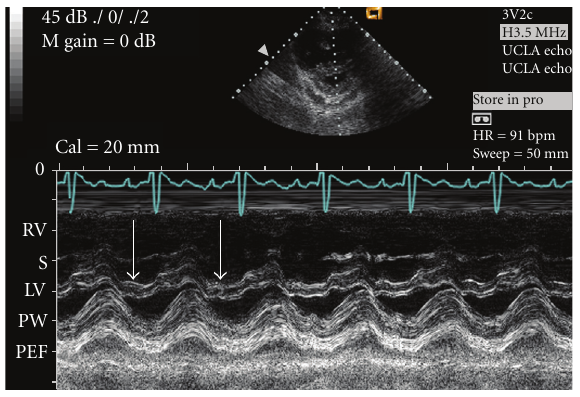
Figure 3: M-mode echo, parasternal short-axis, demonstrating leftward displacement of the septum during diastole (white arrows), consistent with right ventricular volume overload. Right ventricle (RV), septum (S), left ventricle (LV), posterior wall (PW), and pericardial e ff usion